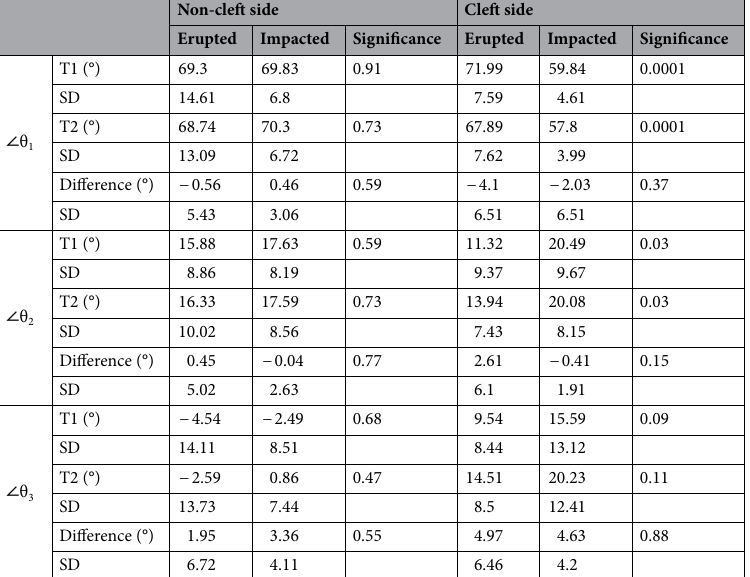
ence was found in the angle of the virtual canine axis with respect to each plane between the erupted and impacted groups in either pre-ABG or post-ABG periods. Results show that ∠ θ 1 on the cleft side of the impacted group (59.84°) was significantly smaller than that of the erupted group (71.99°) at T1 ( p = 0.0001). Additionally, at T2, the ∠ θ 1 of the impacted group (57.80°) was significantly smaller than that of the erupted group (67.89°) ( p = 0.0001). These findings indicate that, pre-ABG, the impacted group was more horizontally inclined to the XY plane than the erupted group was. This inclination was not improved post-ABG. Also, ∠ θ 2 on the cleft side was 11.32° for the erupted group and 20.49° for the impacted group in T1 ( p = 0.03), and 13.94° for the erupted group and 20.08° for the impacted group in T2 ( p = 0.03): both were significantly larger for the impacted group than for the erupted group. These data indicate that the impacted group has more labiolingual tipping than the erupted group pre-ABG. They also indicate that the labiolingual tipping did not improve post-ABG. No signifi- cant difference was found in ∠ θ 3 between the erupted and impacted groups (T1: p = 0.09, T2: p = 0.11), both group canines were not mesial tipping on the cleft sides at T1 and T2.